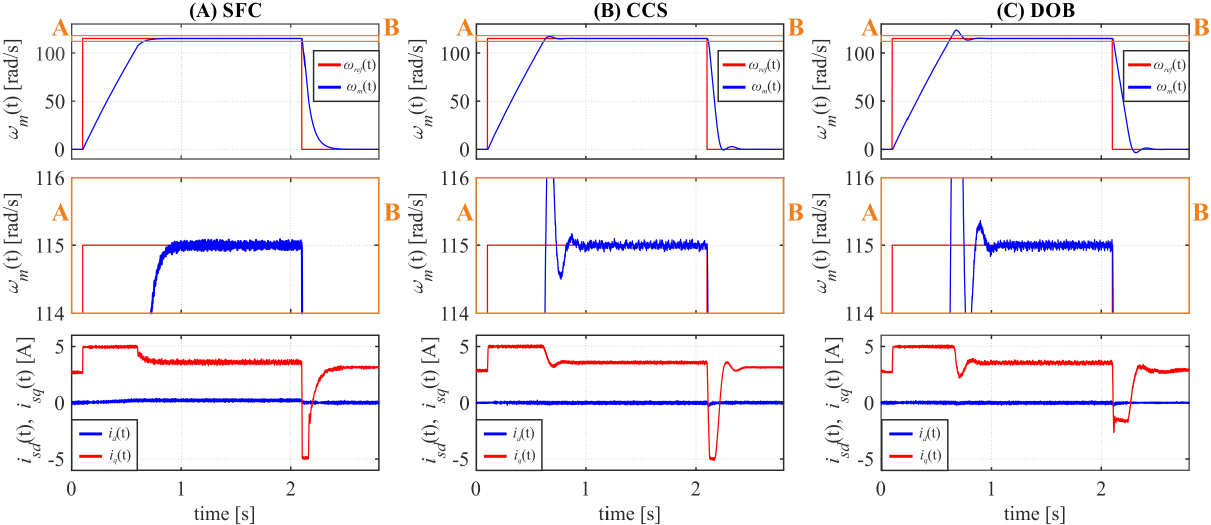
Figure 17. Step response of investigated control structures for the reference signal of 115 rad/s with a constant load (3